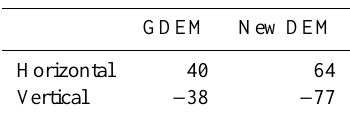
Table 3. Absolute errors in the Ryder Bay region. The table shows the mean di ff erences from the Ryder Bay DEM and GPS points for 10 peaks